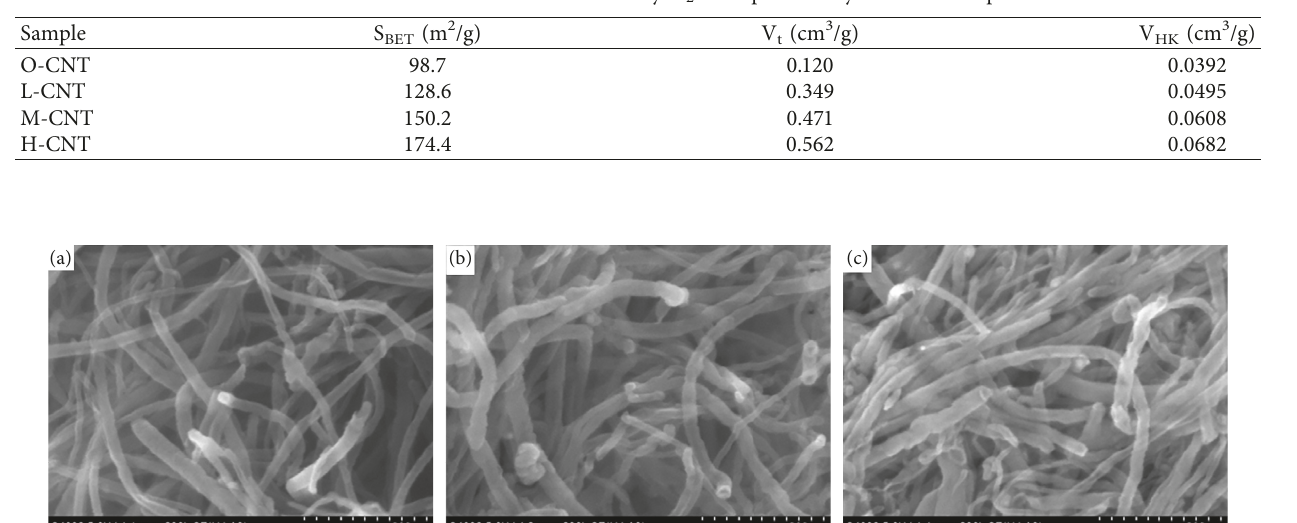
2 adsorption analyses of the samples.